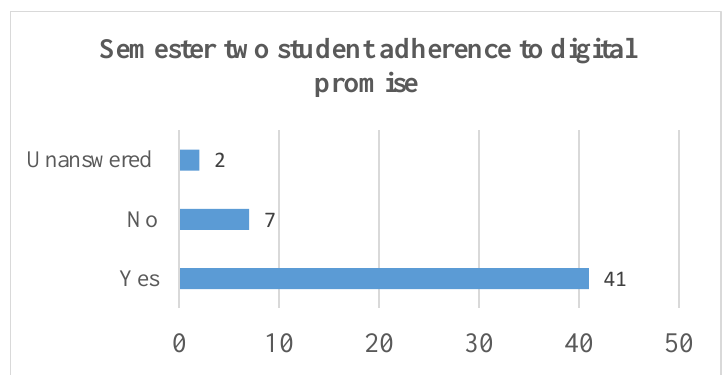
Word Cloud Showing the Importance of the Promise’s Achievement of Student Learning Goals